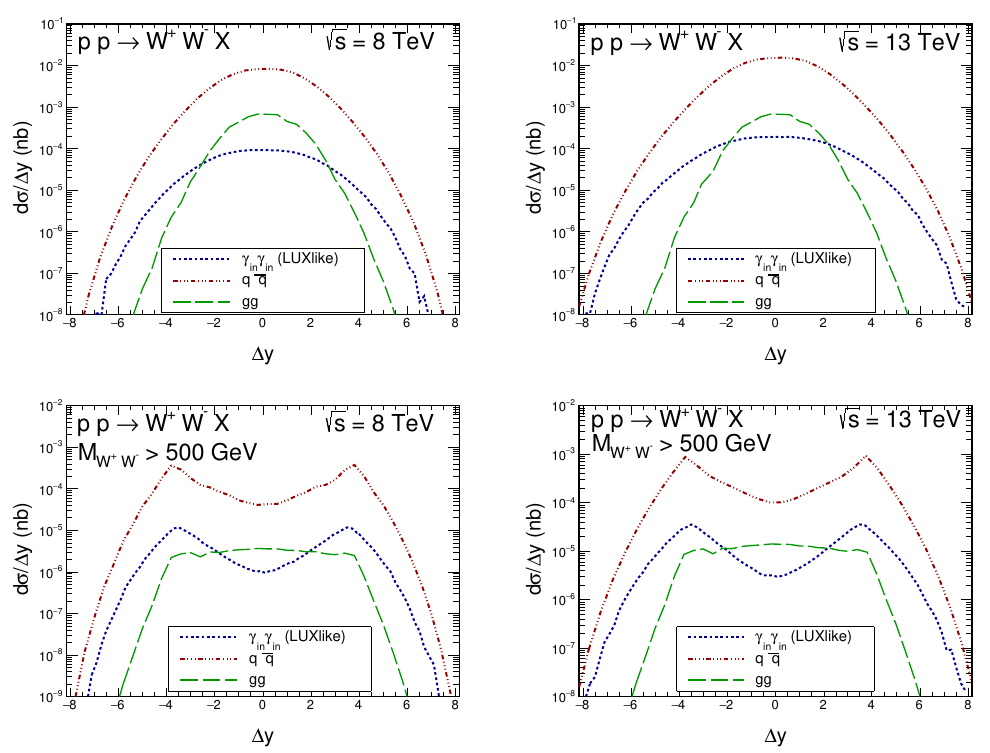
Figure 17 . Distribution in rapidity distance between W bosons. The calculation for the (cid:13) (cid:0) (cid:13) contribution (dotted-line, inelastic-inelastic contribution only) was performed for the LUX-like structure function. The left panel shows results for W = 8 TeV, while the right panel shows results for W = 13 TeV. For comparison we show also contribution of the q (cid:22) q , (cid:22) qq annihilation (dash-dotted line) and gg ! W + W (cid:0) (dashed line). In the lower panels we show results for extra cut imposed on the invariant mass of the M WW system | M WW > 500